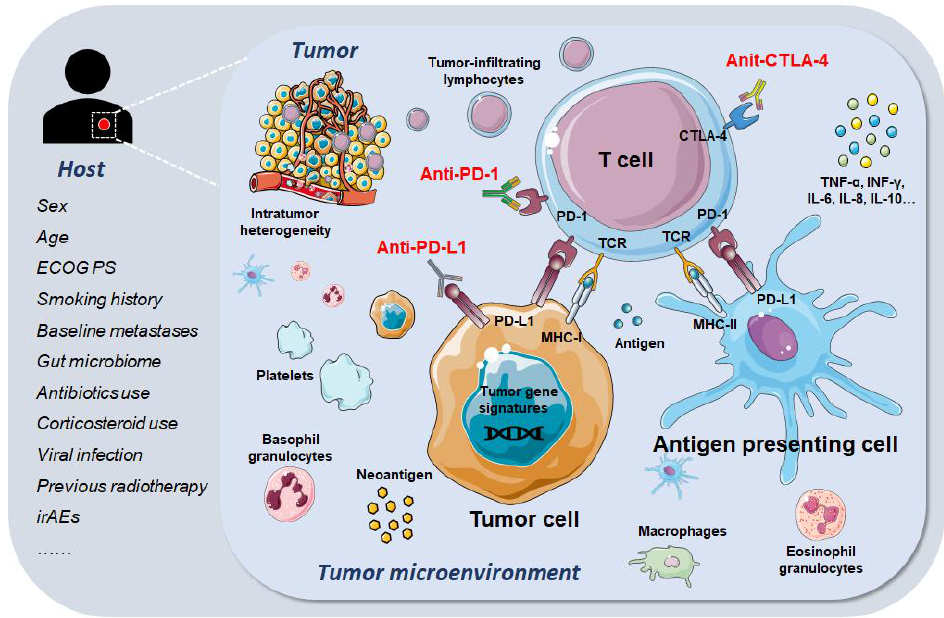
Figure 1. Host – tumor interaction and tumor microenvironment, along with potential biomarkers for immunotherapy. ECOG PS, Eastern Cooperative Oncology Group performance status; irAEs, immune-related adverse events; PD-1, programmed cell death protein 1; PD-L1, programmed death-ligand 1; CTLA-4, cytotoxic T lymphocyte-associated antigen-4; TCR, T cell receptor; MHC-I, Major histocompatibility complex class I; MHC-II, Major histocompatibility complex class II.